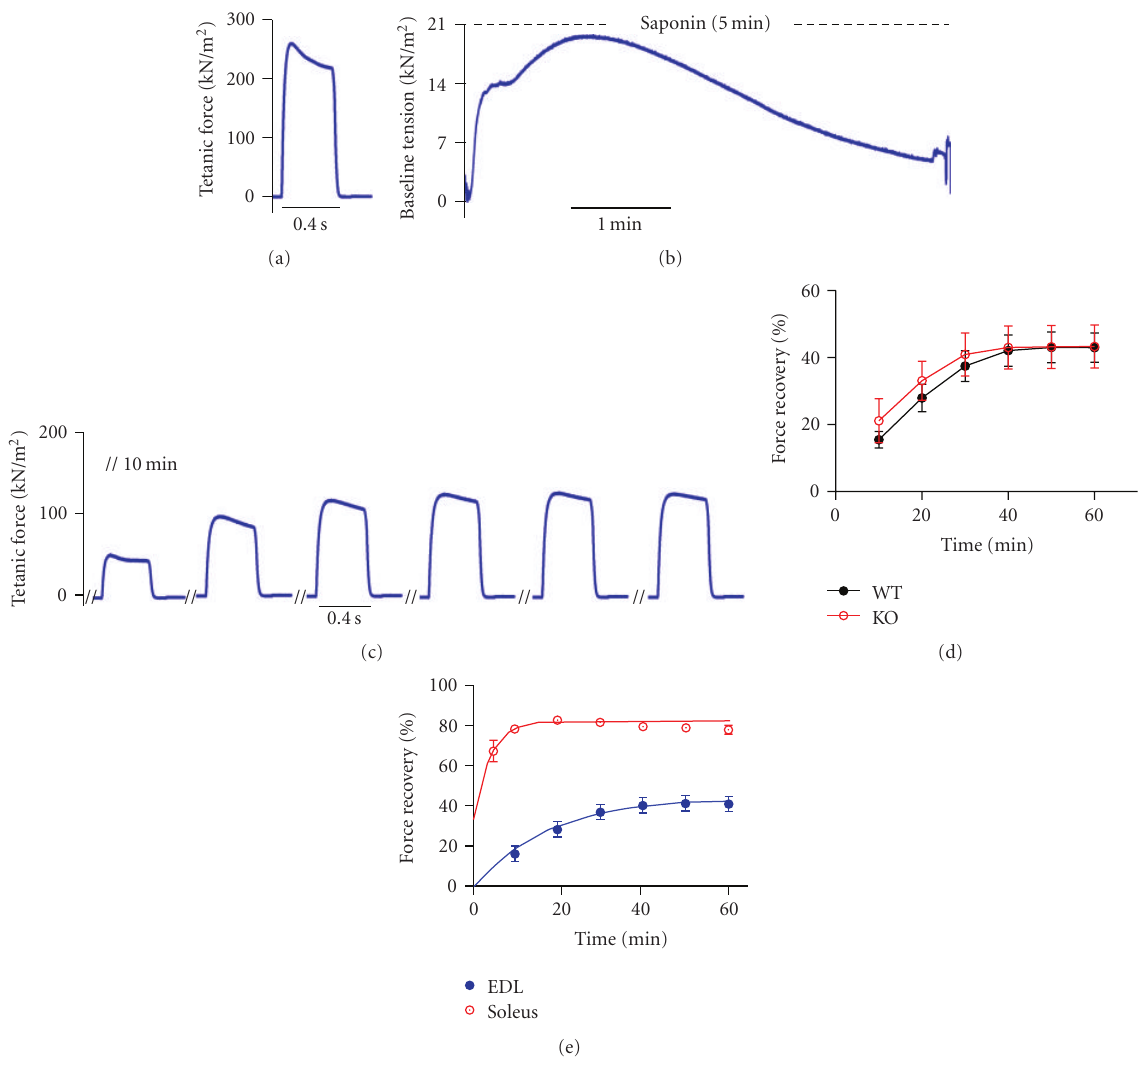
Figure 4: Tetanic force recovery in WT and C57BL/6J-Chr6 A / J /NaJ EDL and soleus muscles following saponin exposure. (a) Representative tetanic force measurement in a WT EDL muscle before saponin exposure. (b) Representative tension trace during saponin (50 μ g/mL) exposure at room temperature (RT). (c) Representative tetanic force measurements within one hour after saponin washout at RT. Double slash: 10 min. (d) Quantitative analysis of the muscle force recovery in EDL muscles of WT and dysferlin-deficient mice at RT. (e) Tetanic force recovery in soleus muscles and EDL muscles ( N = 10 and 13 for EDL and soleus, resp.) after saponin (50 μ g/mL) exposure at room temperature. Note: we pooled the WT and mutant muscle data in panel (e) since there was no significant di ff erence between the two groups (see Tables